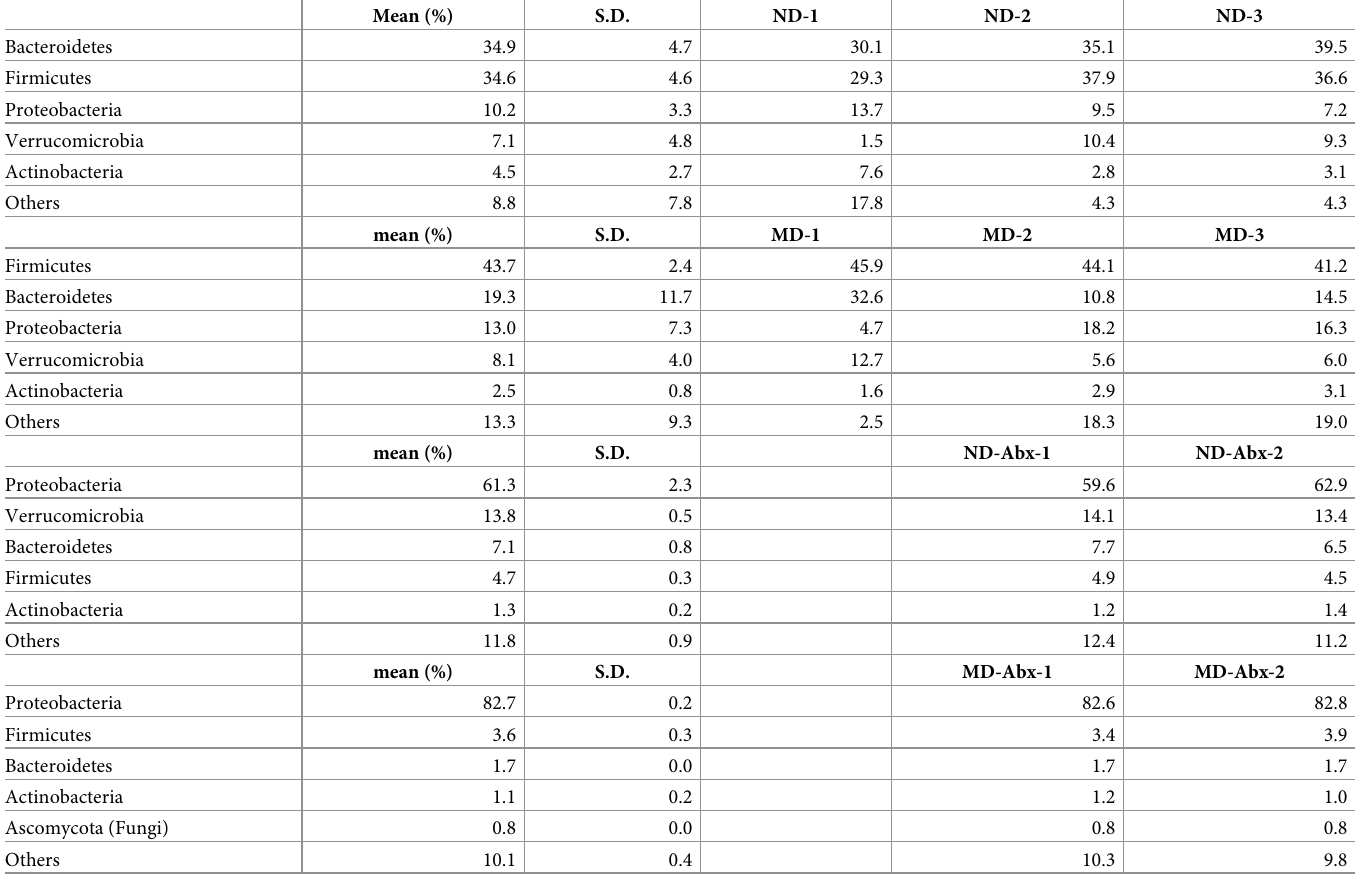
Table 3. Small intestine microbiome compositions of ND, MD, ND+Abx, and MD+Abx, related to Fig 5A. Mean (%)